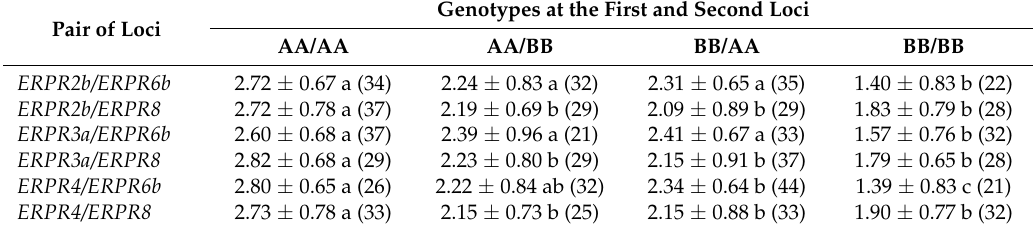
Table 4. Digenic interactions for the pairs of loci ERPR2b/ERPR6b , ERPR2b/ERPR8 , ERPR3a/ERPR6b , ERPR3a/ERPR8 , ERPR4/ERPR6b , and ERPR4/ERPR8. Mean of SCO max ± standard deviation is indicated for each pair of loci. The groups defined by the least significant difference (LSD), just after means and standard deviations. The number of DH lines per genotype class is indicated in parenthesis. “A”: E8 (MM738) allele and “B”: E4 (EG203)